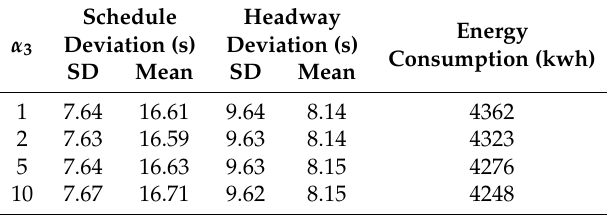
Table 3. The effects of α 3 on the regulation performance.